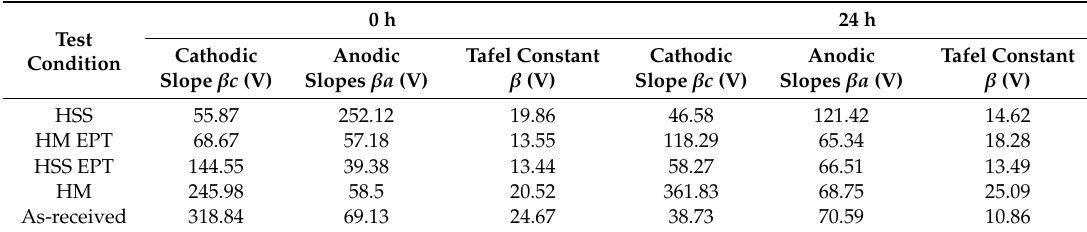
Table 5. Extracted data from the polarization curves on cross sections.